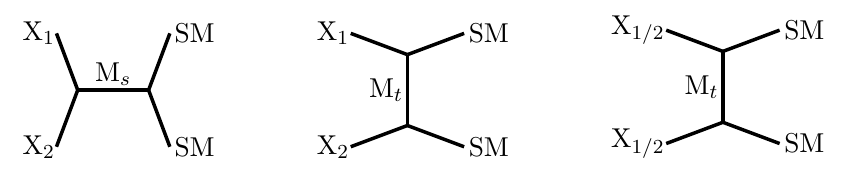
Figure 4 . The mixed annihilation diagram when a new physics mediator is present. The left dia- gram describes the case of an s -channel mediator whereas the middle diagram describes t -channel mediators. The right diagram denotes the modi(cid:12)cation of the self-annihilation rates of the coanni- hilation partners for a t -channel